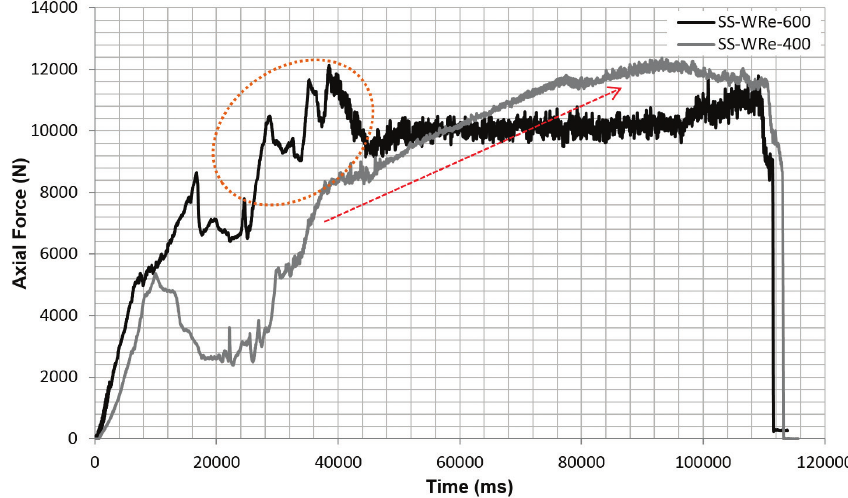
Figure 4. Profiles of axial force versus time of no defect-free welded joints.